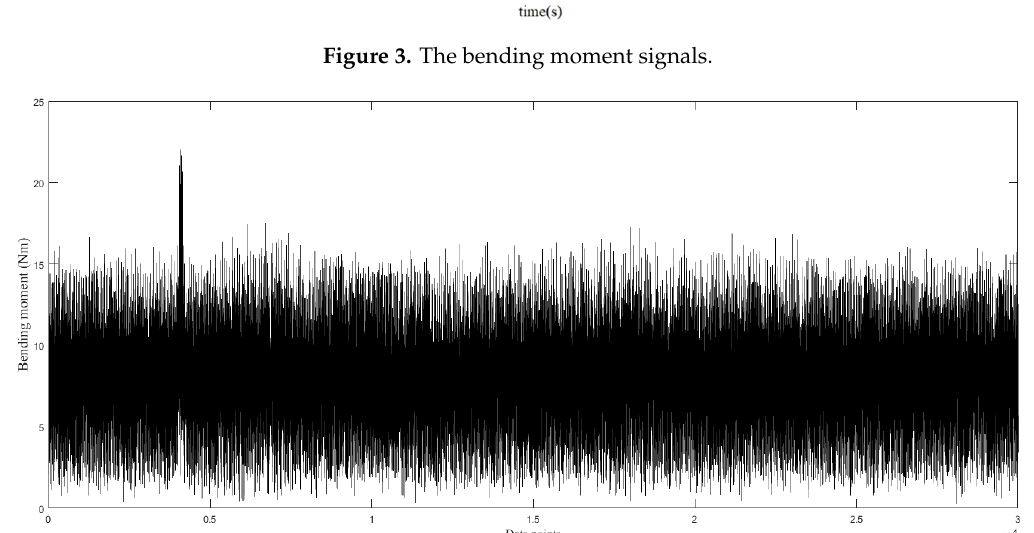
Figure 4. The bending moment signals during cutting process for each surface cutting.